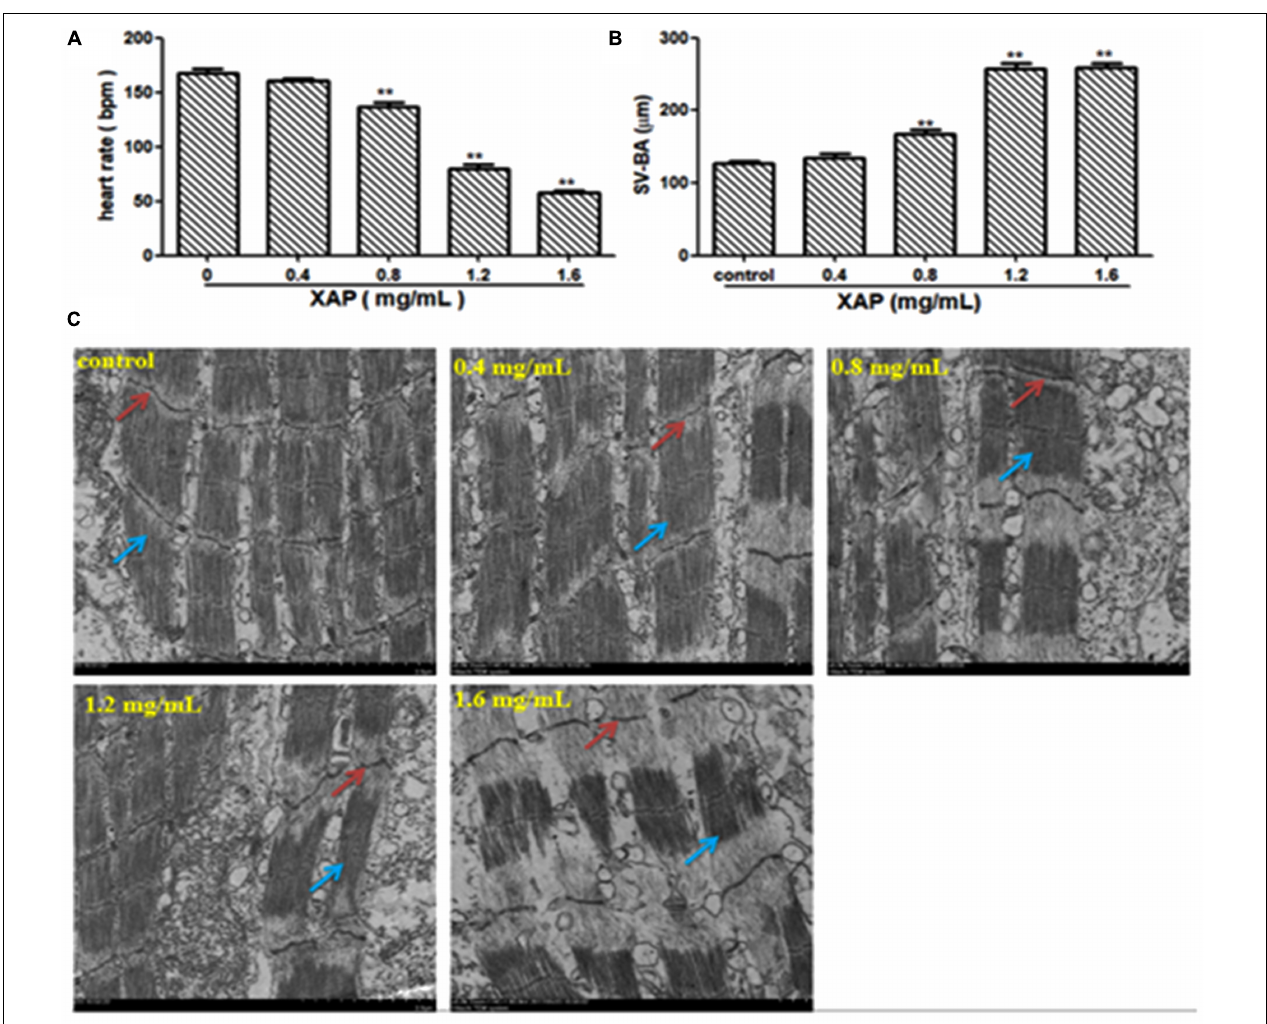
FIGURE 5 | Heart toxicity effects of XAP in zebrafish embryos at 120 hpe. (A) The heart rate (beats/minute) in zebrafish larvae. (B) The SV-BA distance ( µ m) in zebrafish larvae. (C) The TEM image of zebrafish heart. Striated muscle is indicated by a solid red arrow, cardiac muscle fiber is indicated by a solid blue arrow. ∗ P < 0.05, ∗∗ P < 0.01 versus control. SV, sinus venous; BA, bulbus arteriosus; TEM, transmission electron